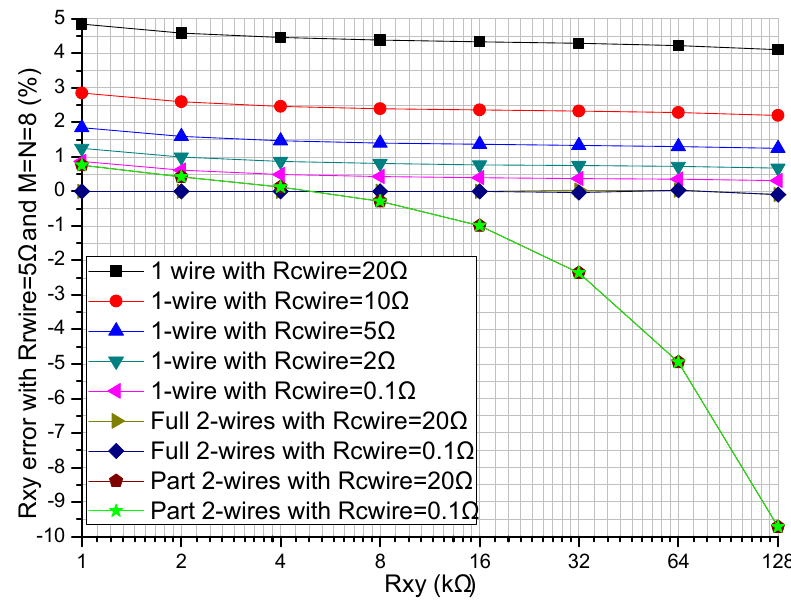
Figure 4. Effect of the R cwire on the R xy errors in the three circuits where R rwire = 5 Ω and M = N = 8.